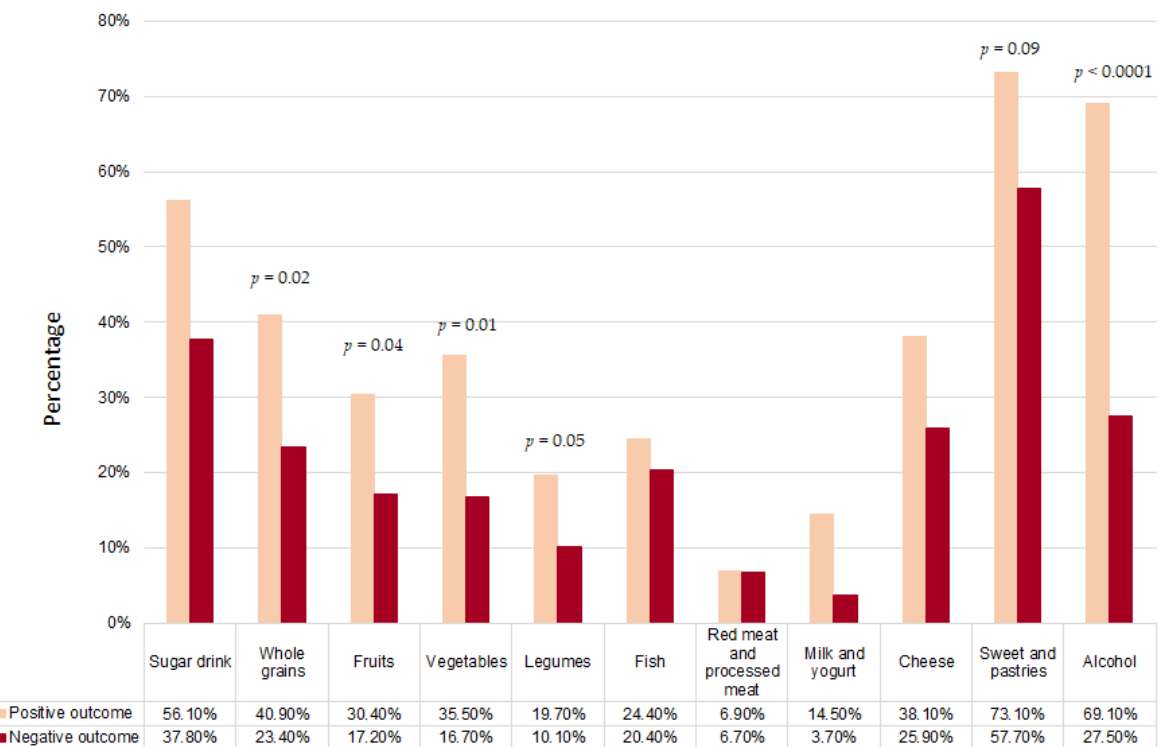
Figure 3. Distribution of women who increased their adherence to Mediterranean diet for each group of food according to ART outcomes (positive outcome vs. negative outcome).